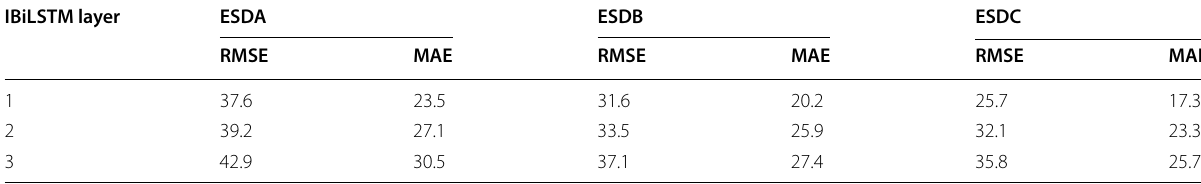
Table 6 Analysis on IBiLSTM layer IBiLSTM layer